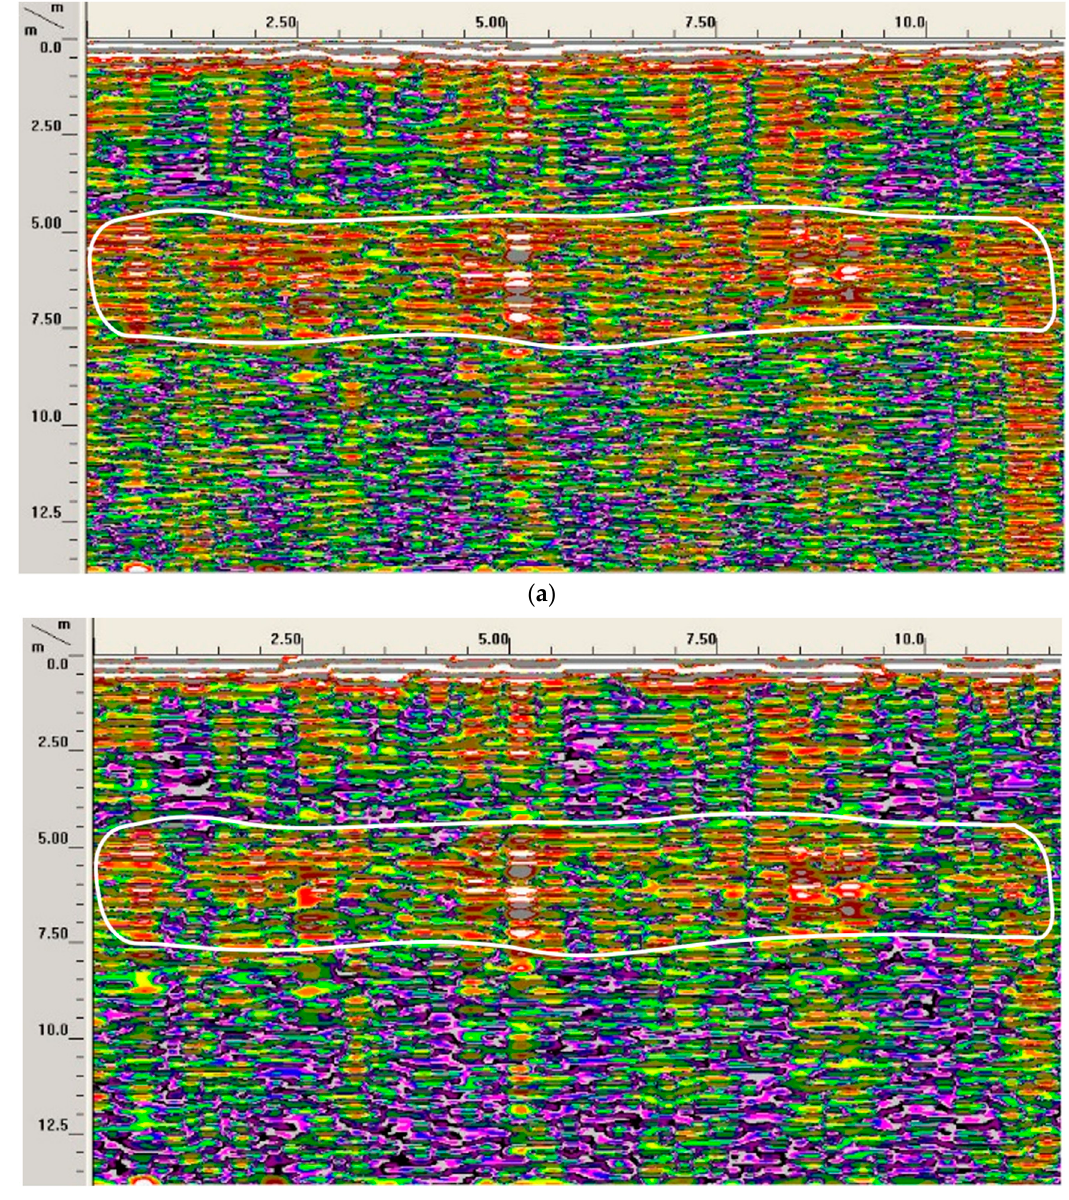
Figure 9. Comparison of images before and after wavelet transform processing of radar signals. (Center frequency: 400 MHz, ( a ) is the preprocessing image, ( b ) is the processed image).